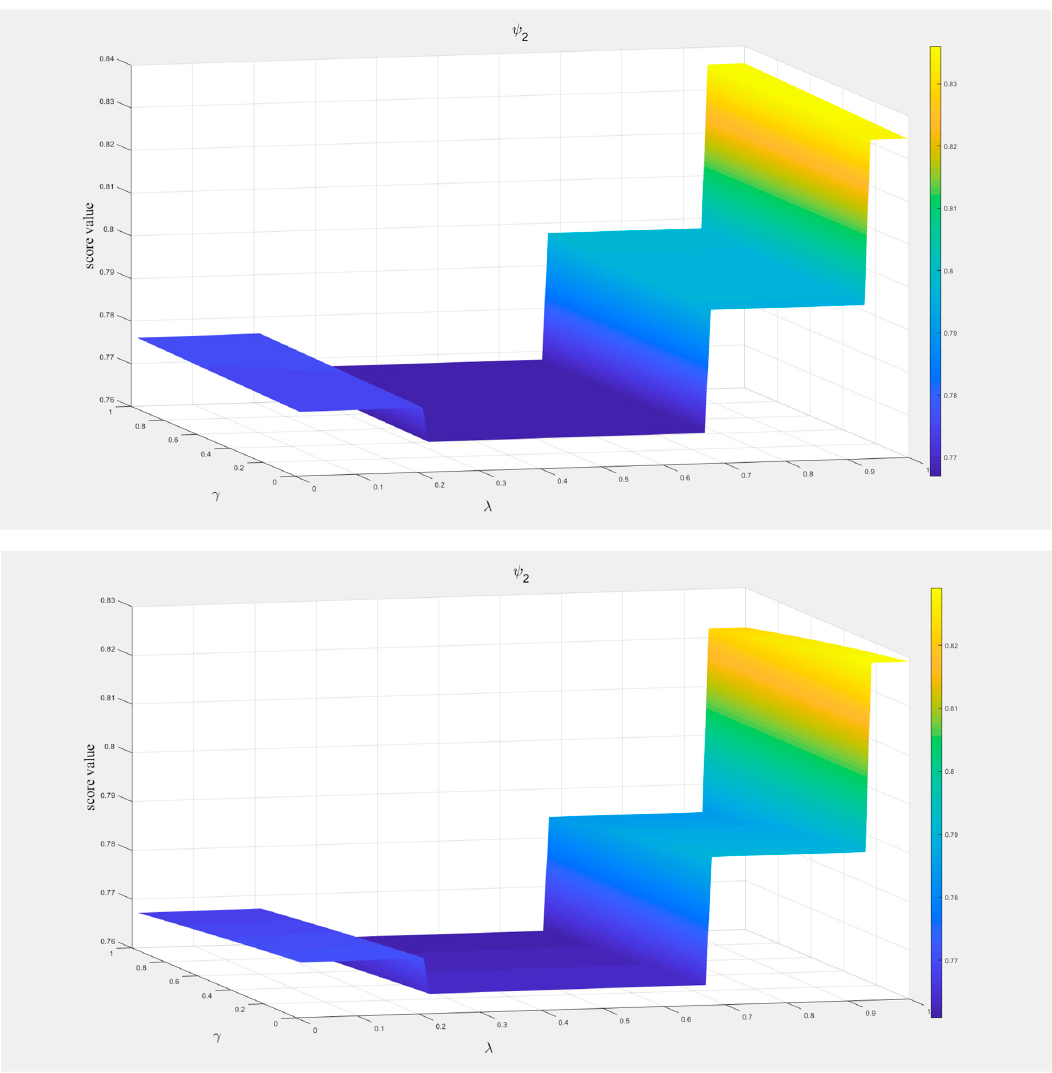
ψ with , (0,1] γλ∈ by using two proposed operators. Figure 2. Score values of 1